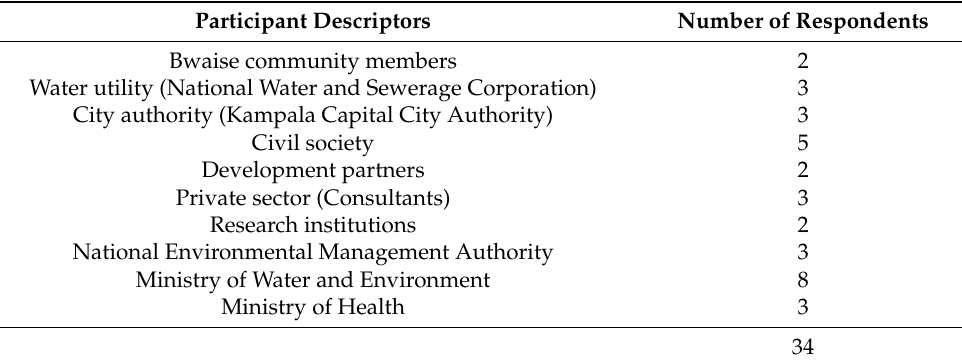
Table 1. Key informant interviews